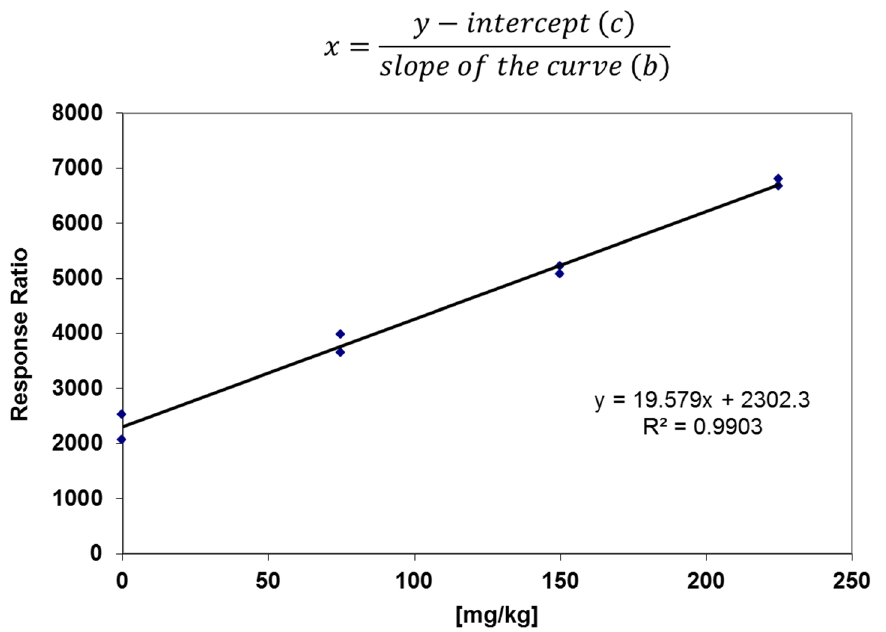
Figure 3. Graphical presentation of the linear regression of the Chickpeans_Flour_b sample.